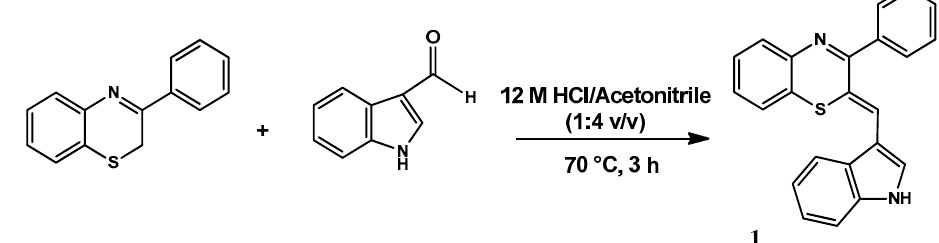
Scheme 2. Synthesis of 2-((1 H -indol-3-yl)methylene)-3-phenyl-2 H -1,4-benzothiazine) ( 1